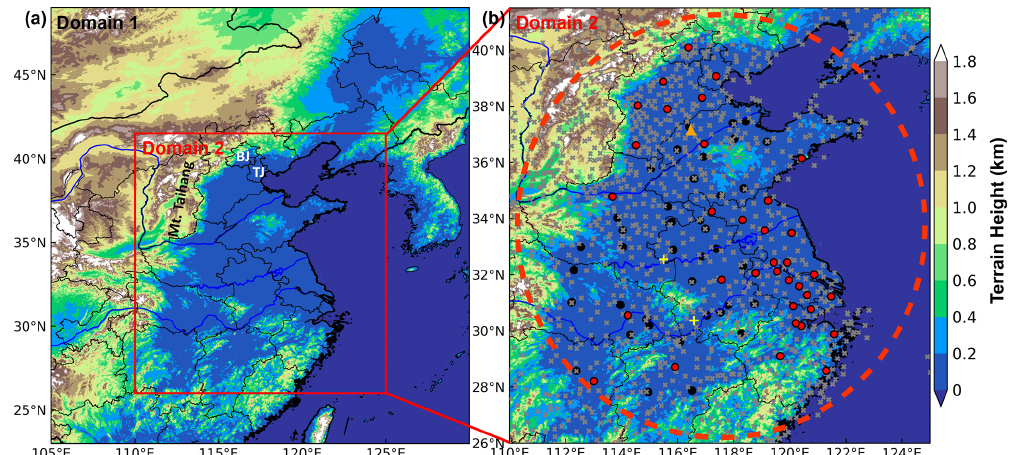
Figure 1. (a) Map of terrain height in the two nested model domains. (b) The locations of surface meteorological stations, air quality monitoring stations and sounding stations are marked by the gray crosses, red (black) dots and yellow pluses, respectively. The turbulence data site is denoted by the orange triangle. The dashed red circle indicates the areas of our primary